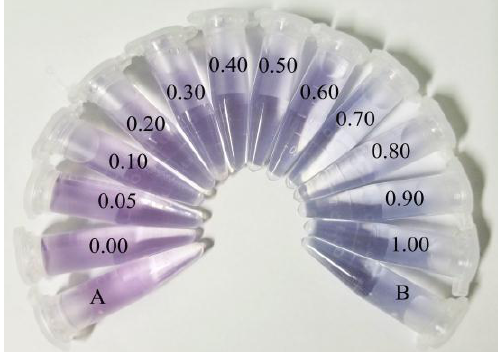
Figure 6. Photograph of the NR-β-CD@AuNPs in the presence of different [NO 2− ] concentrations including 0, 0.05, 0.10, 0.20, 0.30, 0.40, 0.50, 0.60, 0.70, 0.80, 0.90, and 1.00 μg·mL −1 ; A: 0 μg·mL −1 of [NO 2− ] and competing ions; and B: 1.00 μg·mL −1 of [NO 2− ] and competing ions.